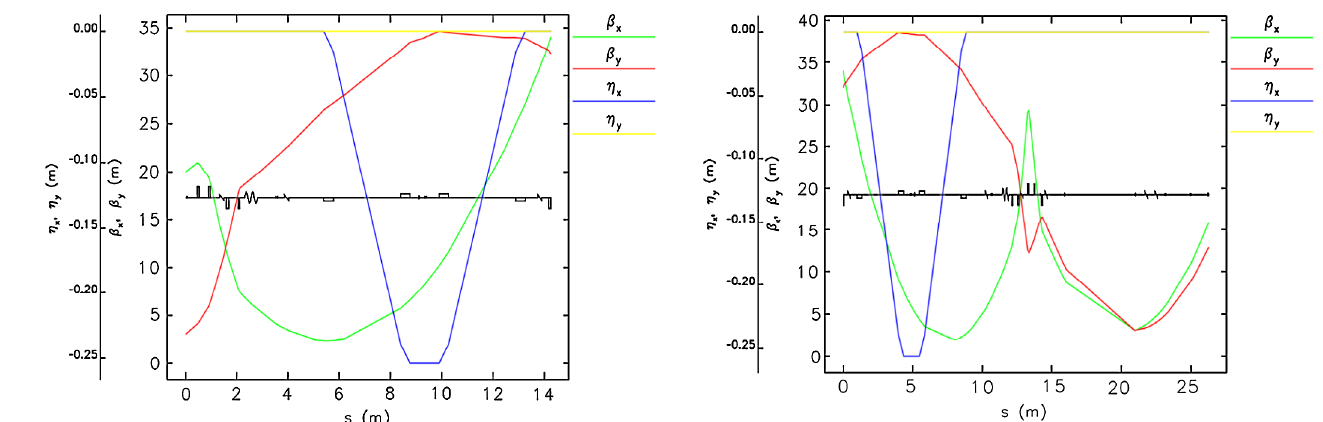
FIG. 3. The optical functions, measured with quadrupole scan in the BC1 area, are back-propagated in the lattice—from the end of the BC1 matching station (left side of the plot) to the entrance of the BC1 magnetic chicane (right side of the plot)—on the basis of the quadrupole strengths read by ELEGANT . The Twiss parame- ters at the entrance of the matching station are thus available to start the matching loop. The result of the matching loop is shown in Fig. 4. The chicane bending angle is set to 85 mrad. The black line in the middle sketches the machine layout.